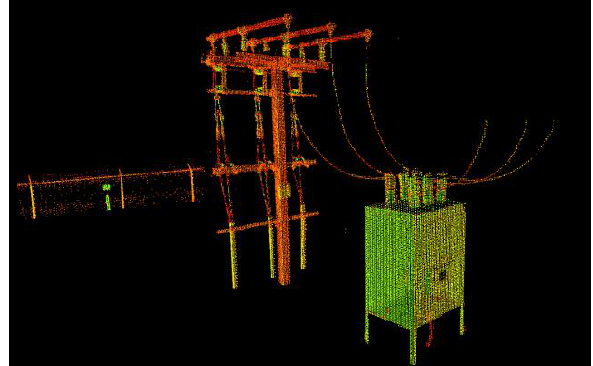
Figure 5. The subset used in this research scanned by the Leica scanner